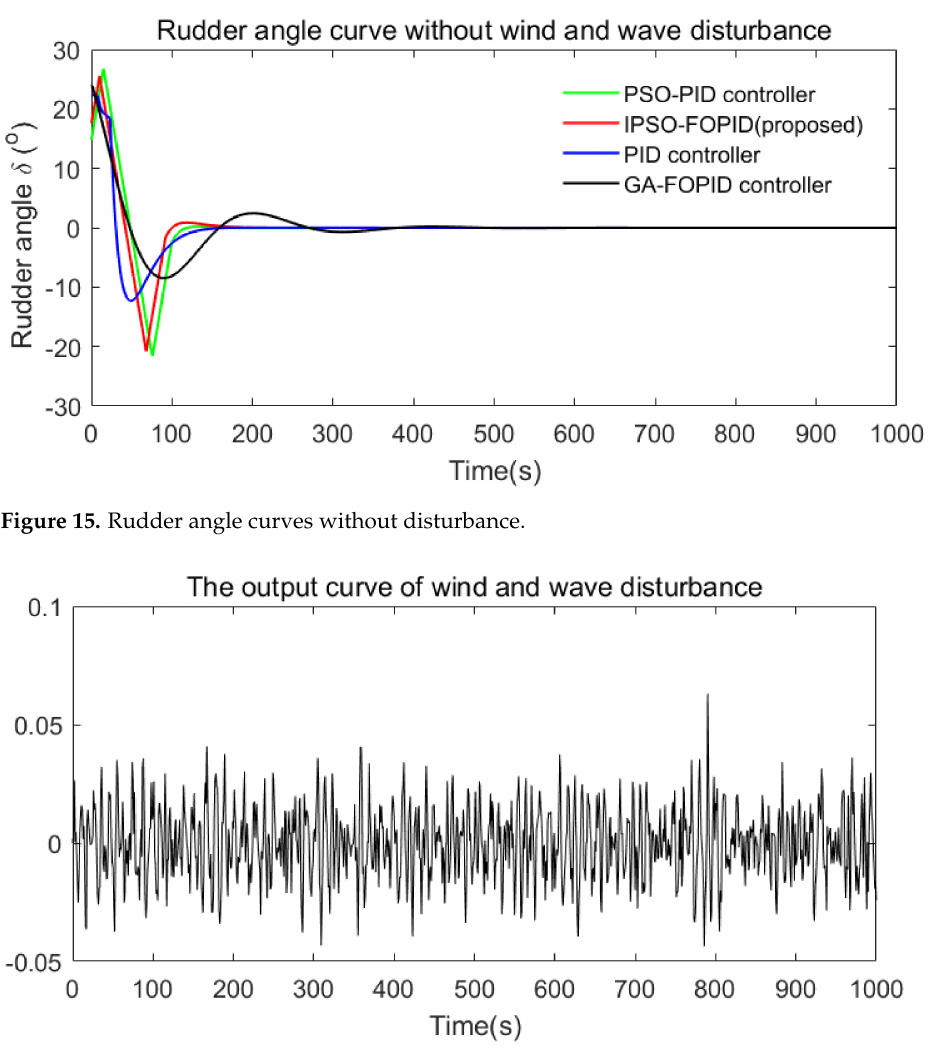
Figure 16. The output curve of wind and wave